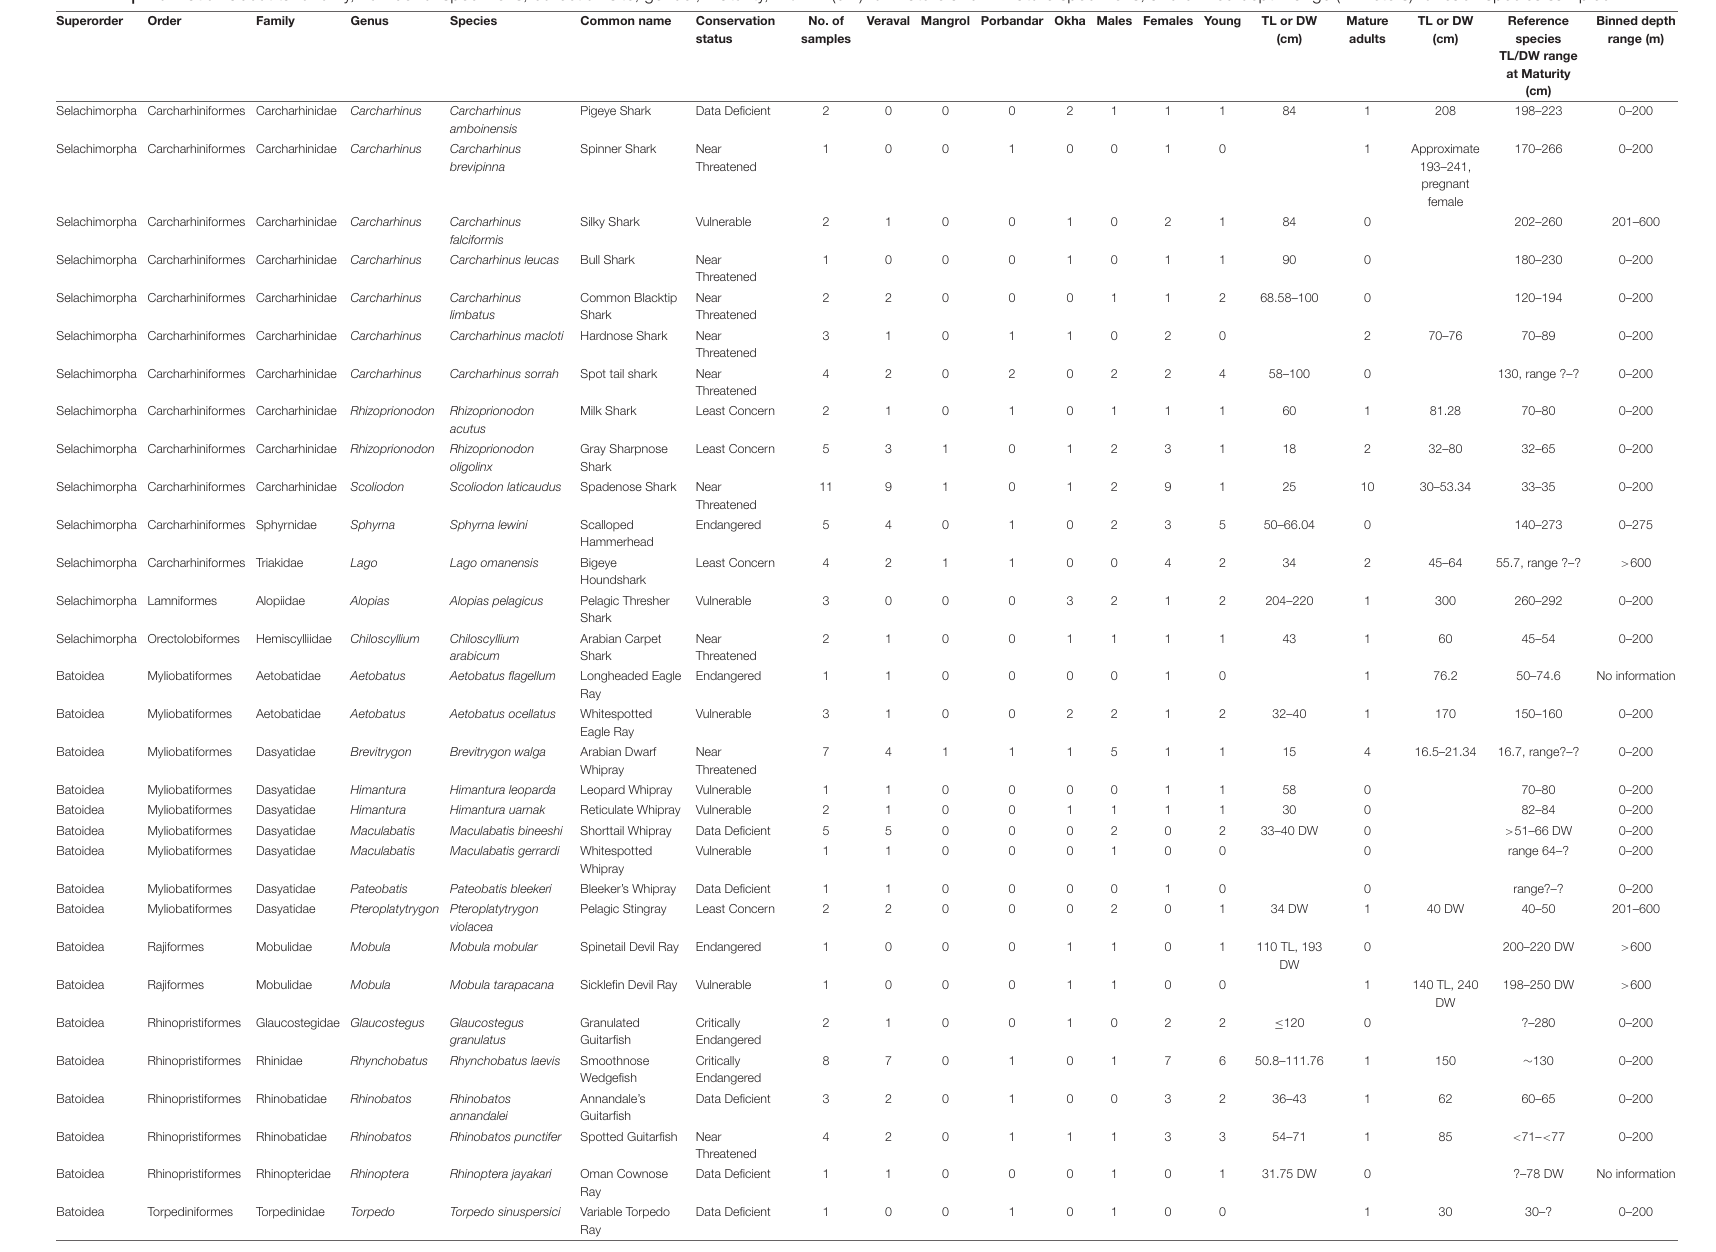
TABLE 2 | Information about taxonomy, number of specimens, collection site, gender, maturity, TL/DW (cm) for mature and immature specimens, and binned depth range (in meters) for each species sampled. Superorder Order